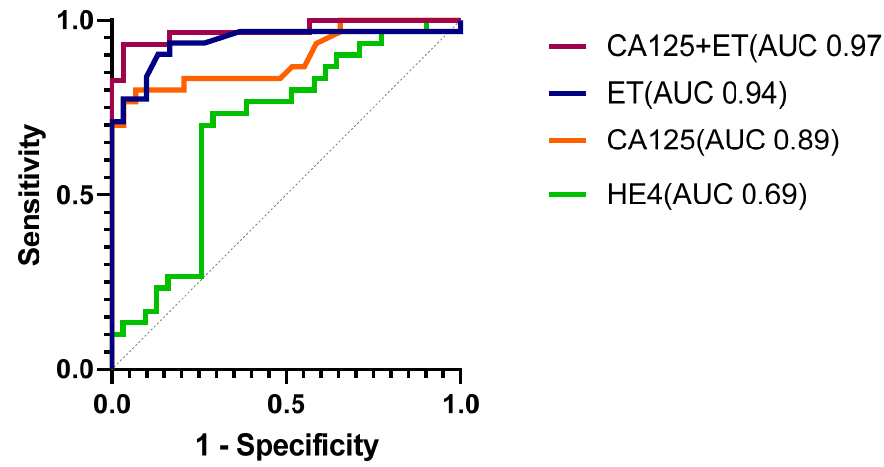
Figure 4. ROC curve analyses indicating the overall performance of urine CA125, HE4, endometrial thickness (ET), and a model combining CA125 and ET for the detection of endometrial cancer. AUC: Area under the curve.